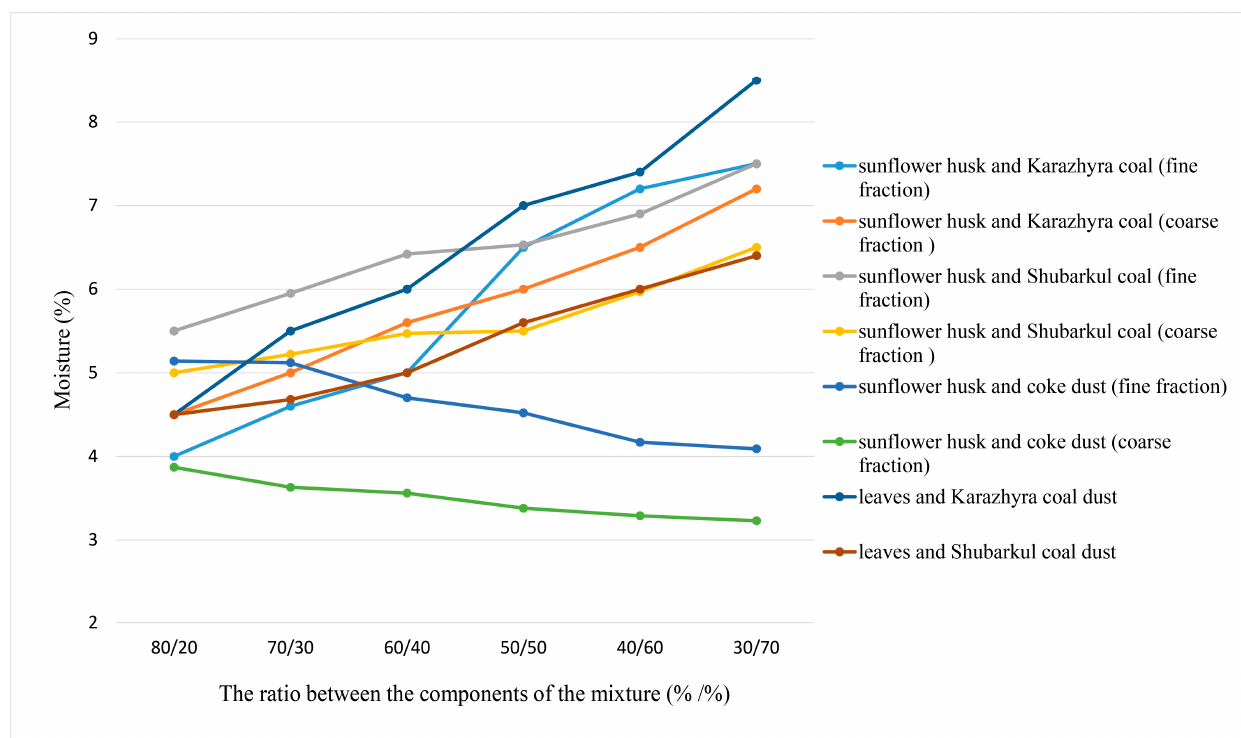
Figure 3. The dependence of the moisture content of briquettes on the type and ratio of the compo- nents of the bio-coal mass.